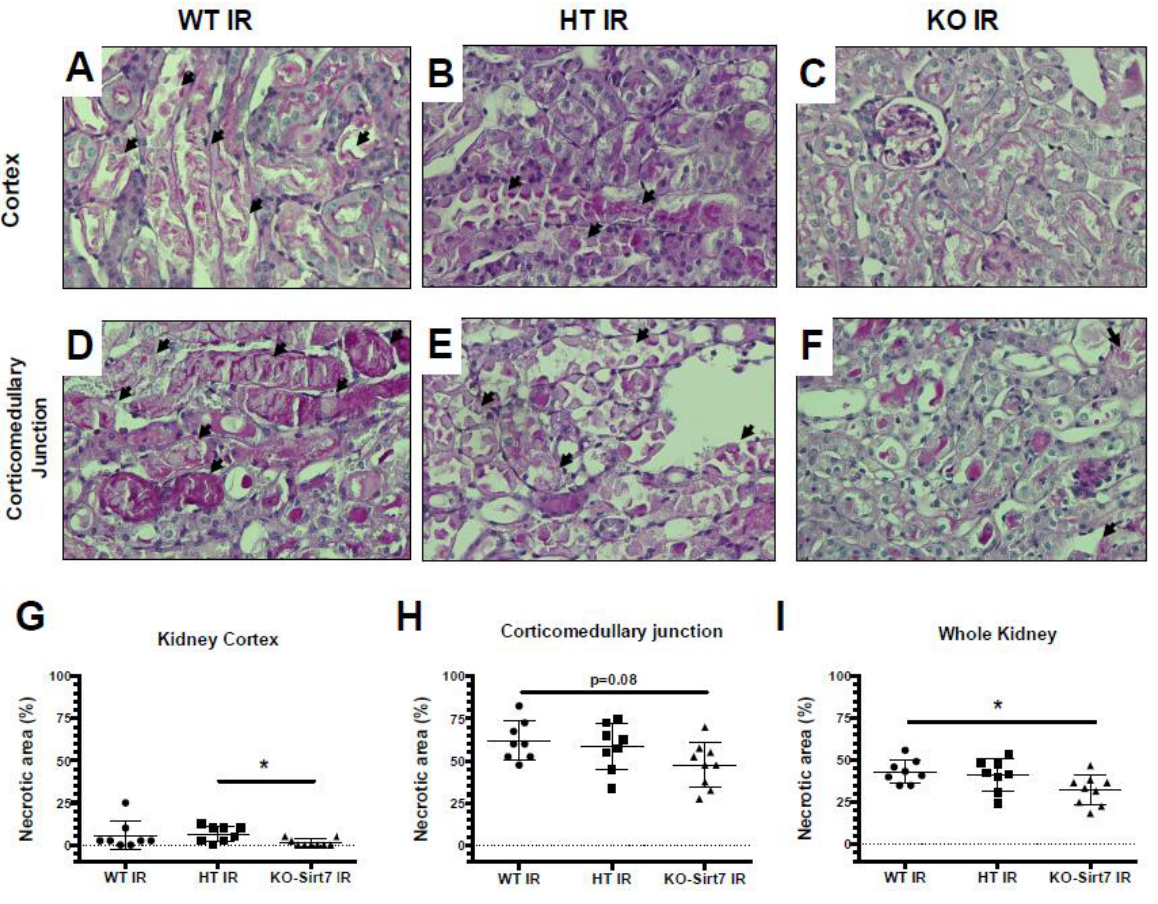
Figure 3. Sirt7 deficiency ameliorated tubular necrosis after IR. ( A – F ) Representative PAS images showing necrotic debris (arrows) in kidney cortex (upper panels) and corticomedullary junction (lower panels) of mice subjected to IR. All animals subjected to sham surgery exhibited null necrotic area (not shown). ( G – I ) Quantitative analysis of necrotic area in kidney cortex ( G ), corticomedullary junction ( H ), and whole kidney ( I ), indicated lesser tubular injury in KO-Sirt7 animals. * p < 0.05 between the indicated groups.